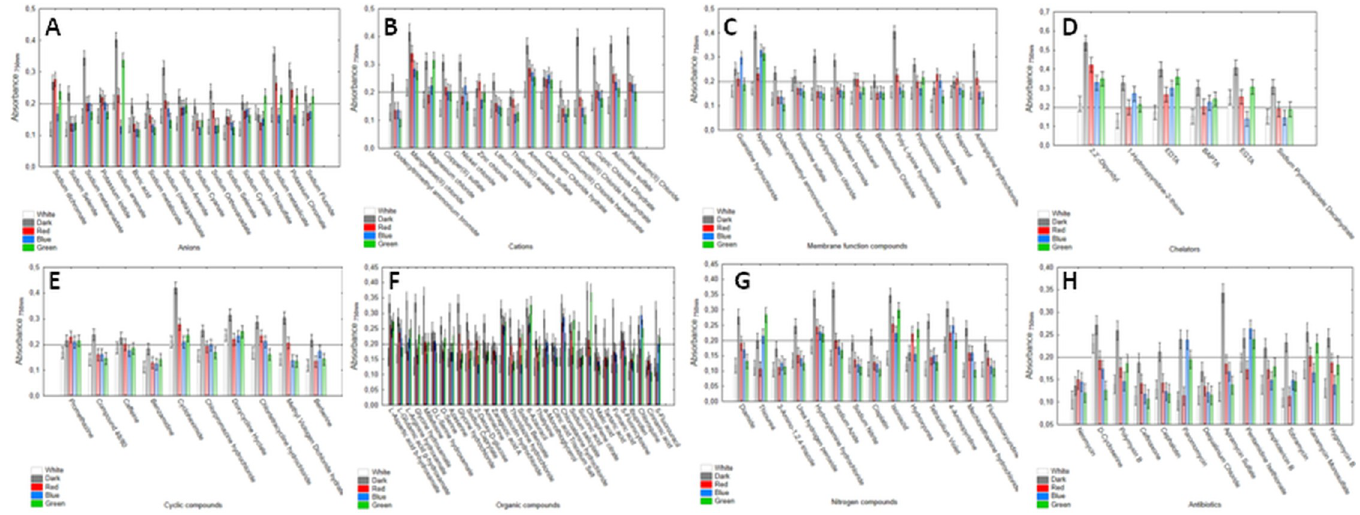
Fig 7. C . unicolor growth in different lighting treatments (white, red, blue and, green light, darkness) in the presence of A–anions, B–cations, C–membrane function-affecting compounds, D–chelators, E–cyclic compounds, F–organic compounds, G–nitrogen compounds, and H–antibiotics. The scales represent growth values (OD 750 nm) after 10 days of incubation. The horizontal line at a value of 0.2 represents the growth threshold considered positive. Vertical bars denote 0.95 confidence